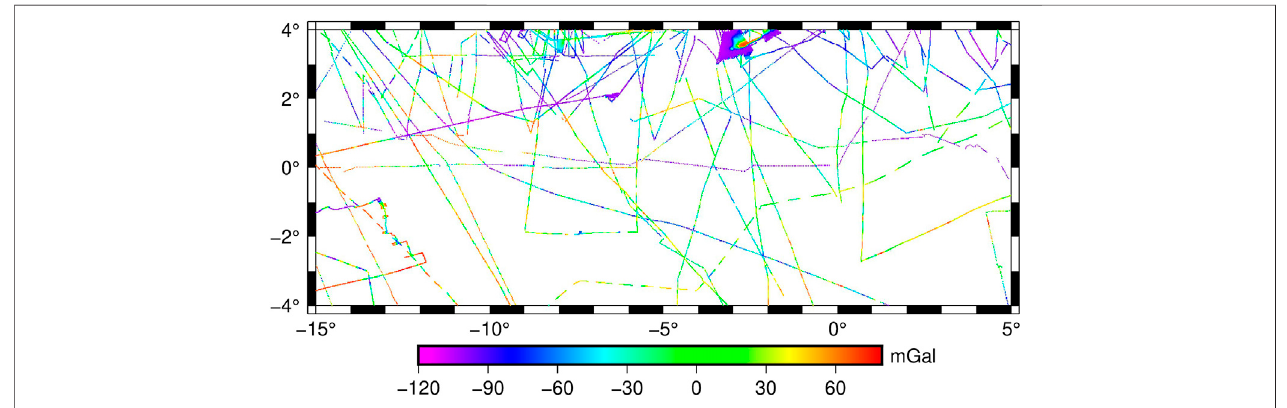
FIGURE 7 | Shipborne gravity anomalies over the study